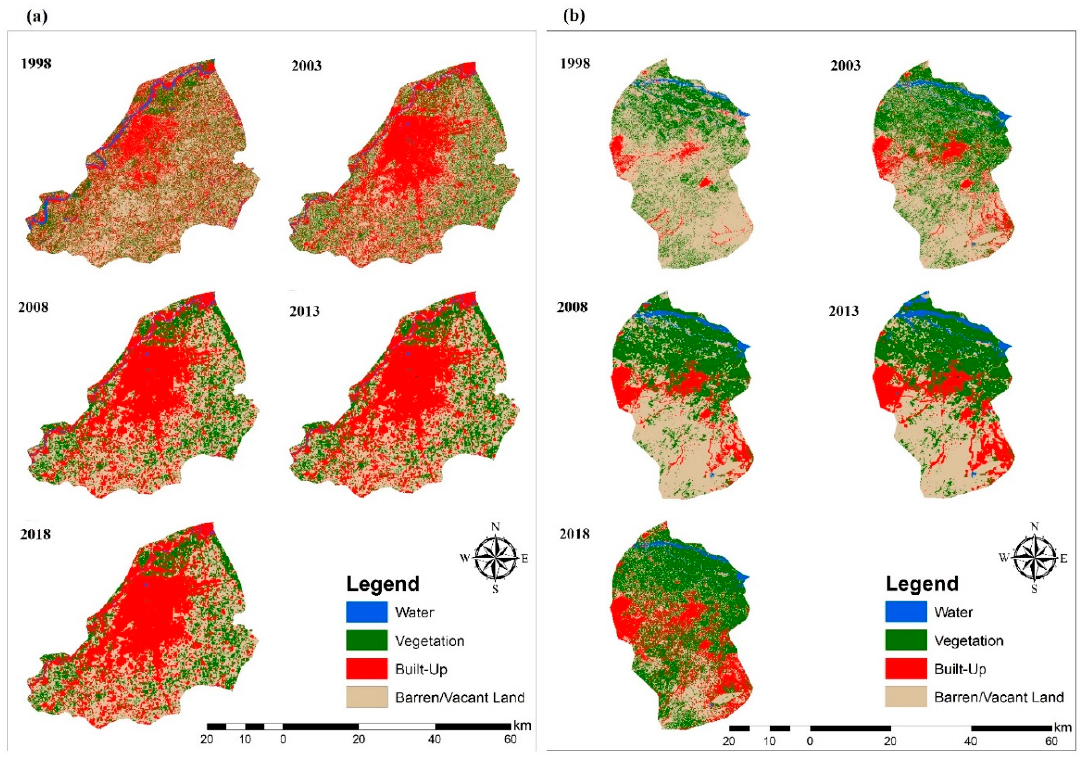
Figure 3. Spatial patterns of land use land cover (LULC) in Lahore (a) and Peshawar (b) . Table 2. Accuracy assessment of land use classification in Lahore and Peshawar (%).